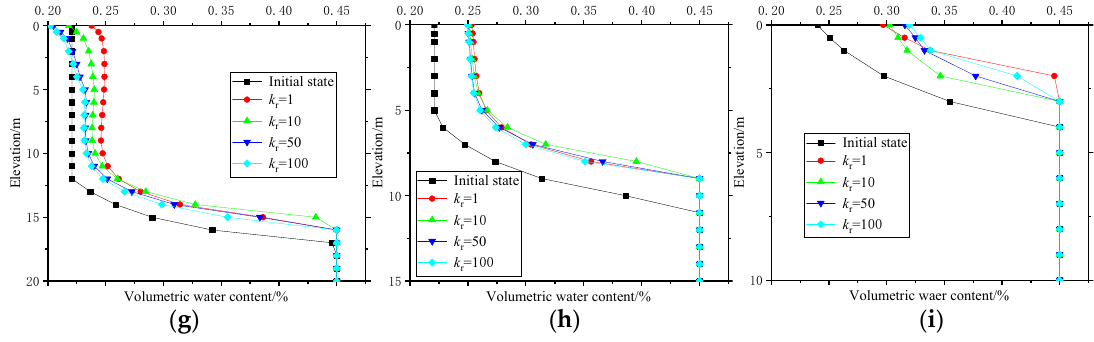
Figure 6. Variation of volumetric water content under different k r values for sandy soil. ( a ) Top of the slope with α = 0°. ( b ) Middle of the slope with α = 0°. ( c ) Toe of the slope with α = 0°. ( d ) Top of the slope with α = 45°. ( e ) Middle of the slope with α = 45°. ( f ) Toe of the slope with α = 45°. ( g ) Top of the slope with α = 90°. ( h ) Middle of the slope with α = 90°. ( i ) Toe of the slope with α = 90°.